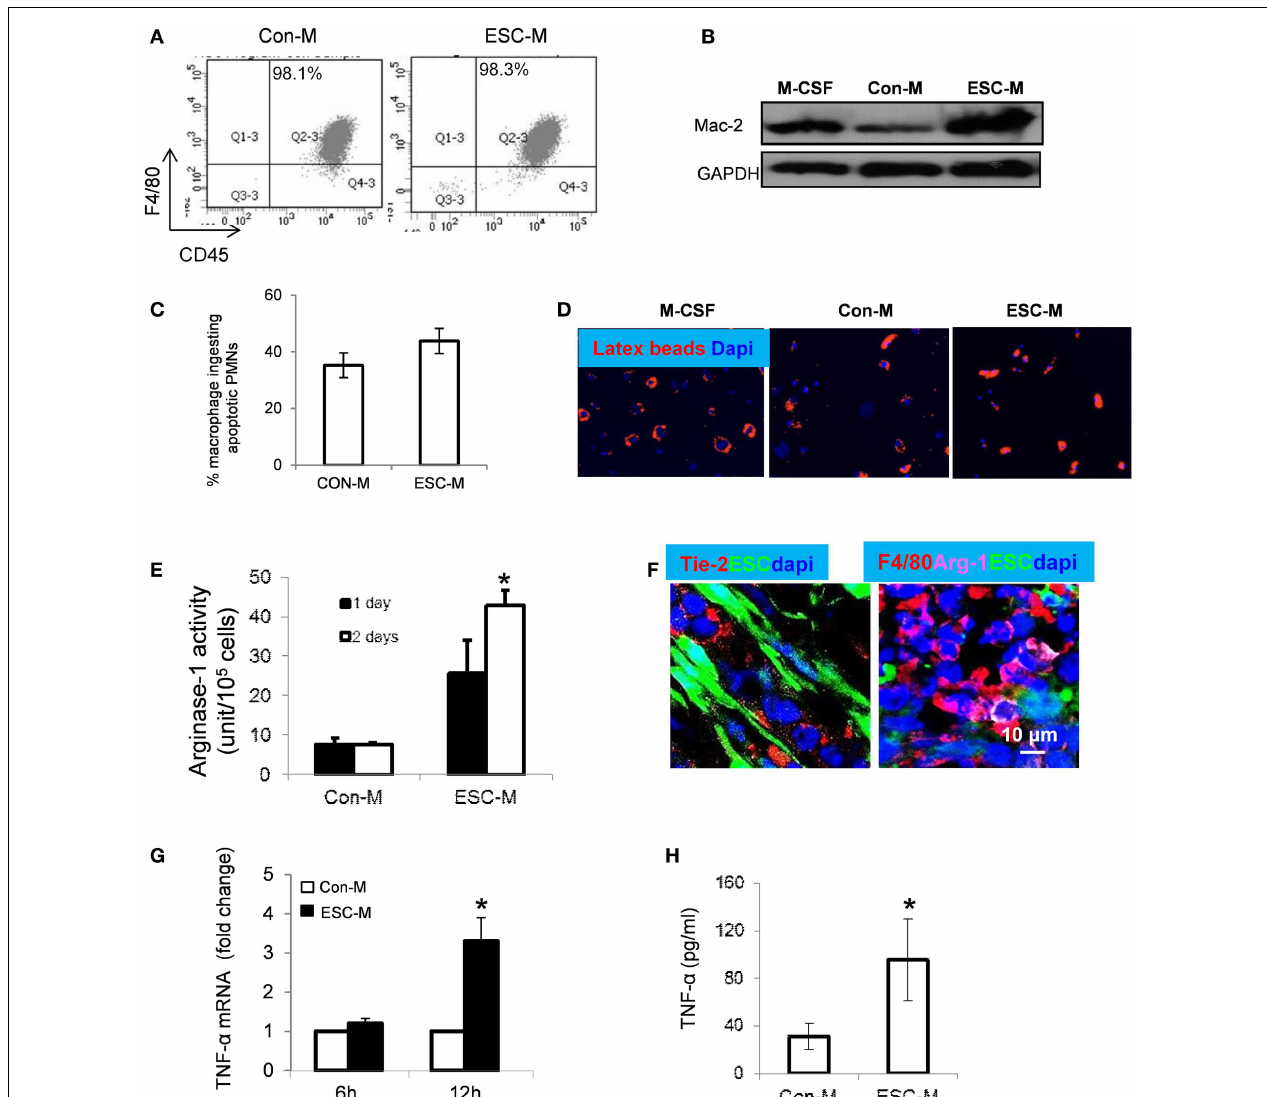
colorimetric assay ( n = 3, * p < 0.05, two-sidedWilcoxon test. Data are represented as mean ± SEM). (F) Representative confocal images of immunostaining of sections from mice at 2weeks after ESC injection showing positive staining forTie-2 (red, left) and F4/80 (red, right) Arginase-1 (purple), respectively. (G) TNF- α mRNA in BMDMs treated with Con-M and ESC-M for 6 and 12h was detected by real time RT-PCR ( n = 4, * p < 0.05, two-sidedWilcoxon test. Data are represented as mean ± SEM). (H) TNF- α in the supernatants of BMDMs treated with Con-M and ESC-M for 48h was detected by ELISA ( n = 3, * p < 0.05, two-sidedWilcoxon test. Data are represented as mean ±